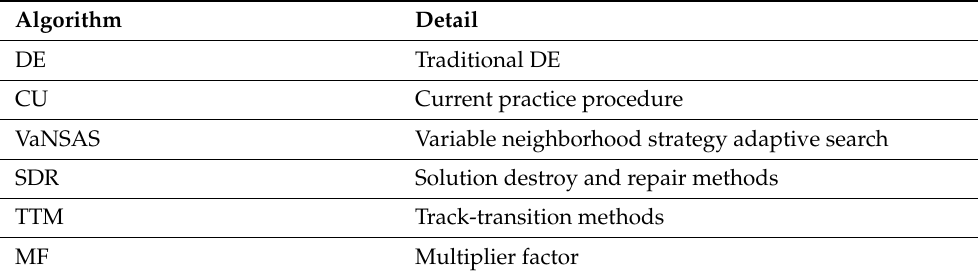
Table 8. Proposed-method details.